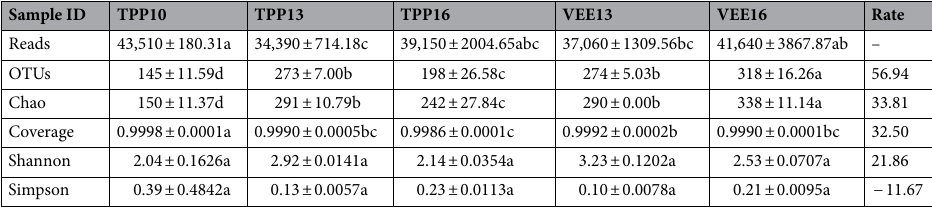
Table 1. Comparison of α-diversity indices in TPP and VEE soil samples. “Rate” refers to the growth rate of VEE16 over TPP16. Means followed by the same letter a, b or c indicates there is no significant difference among the treatments at p < 0.05 (n = 3), Number after “+/−” represents the standard deviation. TPP means a traditional planting pattern while VEE means a vegetable–eel–earthworm integrated planting and breeding